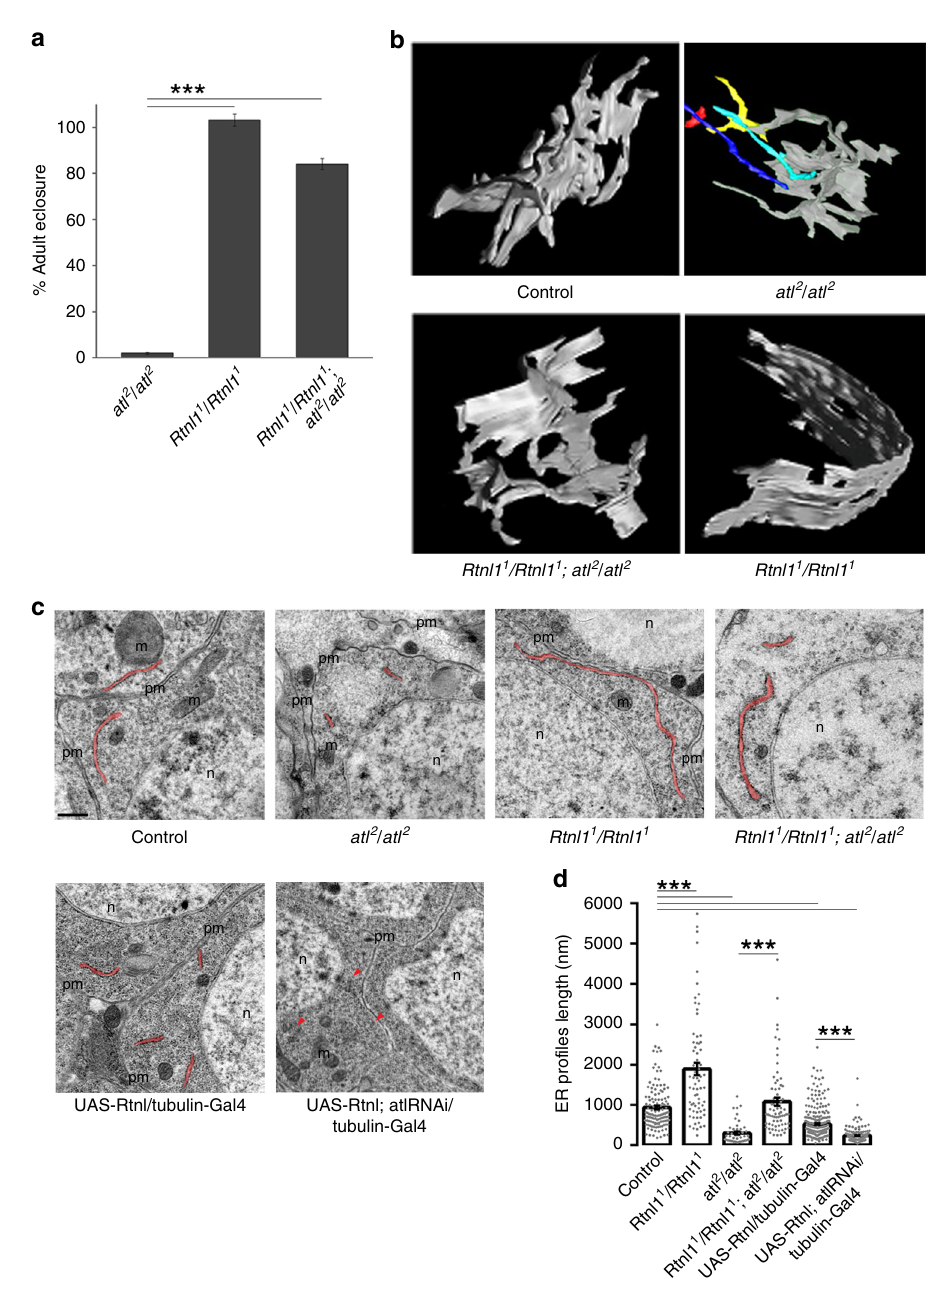
Fig. 1 The genetic antagonism between Rtnl1 and atlastin in Drosophila is re fl ected in morphological alterations of the ER. a The histogram displays the percentage of surviving adults, expressed as the ratio of observed over expected individuals, for the indicated genotypes. n = 3 independent experiments, statistical signi fi cance: unpaired two-tailed t test, *** p < 0.001. Error bars represent SEM. b EM tomography-based 3D reconstruction of portions of the ER network from neurons of the indicated genotypes. ER elements not connected are shown in color. Scale bar 200 nm. c Representative EM images of ventral ganglion neuronal bodies of the indicated genotypes highlighting ER pro fi les in red. Scale bar 0.5 μ m. pm plasma membrane, m mitochondria, n nucleus. d average length of ER pro fi les measured on thin EM sections shown in ( c ), n > 100 ER pro fi les. Statistical signi fi cance: unpaired two-tailed t test, *** p < 0.001. Error bars represent SEM. Source data are provided as a Source Data fi that atlastin counters the reduction of ER pro fi le length mediated by either endogenous or transgenic Rtnl1 and that the atlastin/ Rtnl1 ratio controls ER pro fi le length (Supplementary Fig 1d, e), a parameter that can thus be used as a measure of the functional antagonism between Rtnl1 and atlastin in vivo.